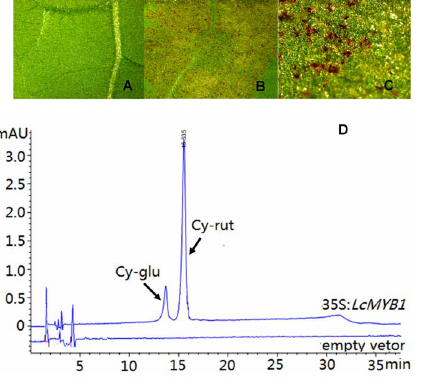
Figure 5. Color development in Nicotiana tabacum leaves following transient transformation. Microscopic images showing anthocyanin accumulation in tobacco leaf infiltrated with: A) an empty vector (1 6 magnification) or B–C) 35S:LcMYB1 (8 6 magnification). D) Anthocyanin HPLC profiles of 35S:LcMYB1 extracts from tobacco leaf (top line) and empty vector (bottom line). Peaks identified at 520 nm: cy-glu, cyanidin-3-glucoside; cy-rut, cyanidin-3-rutinoside.